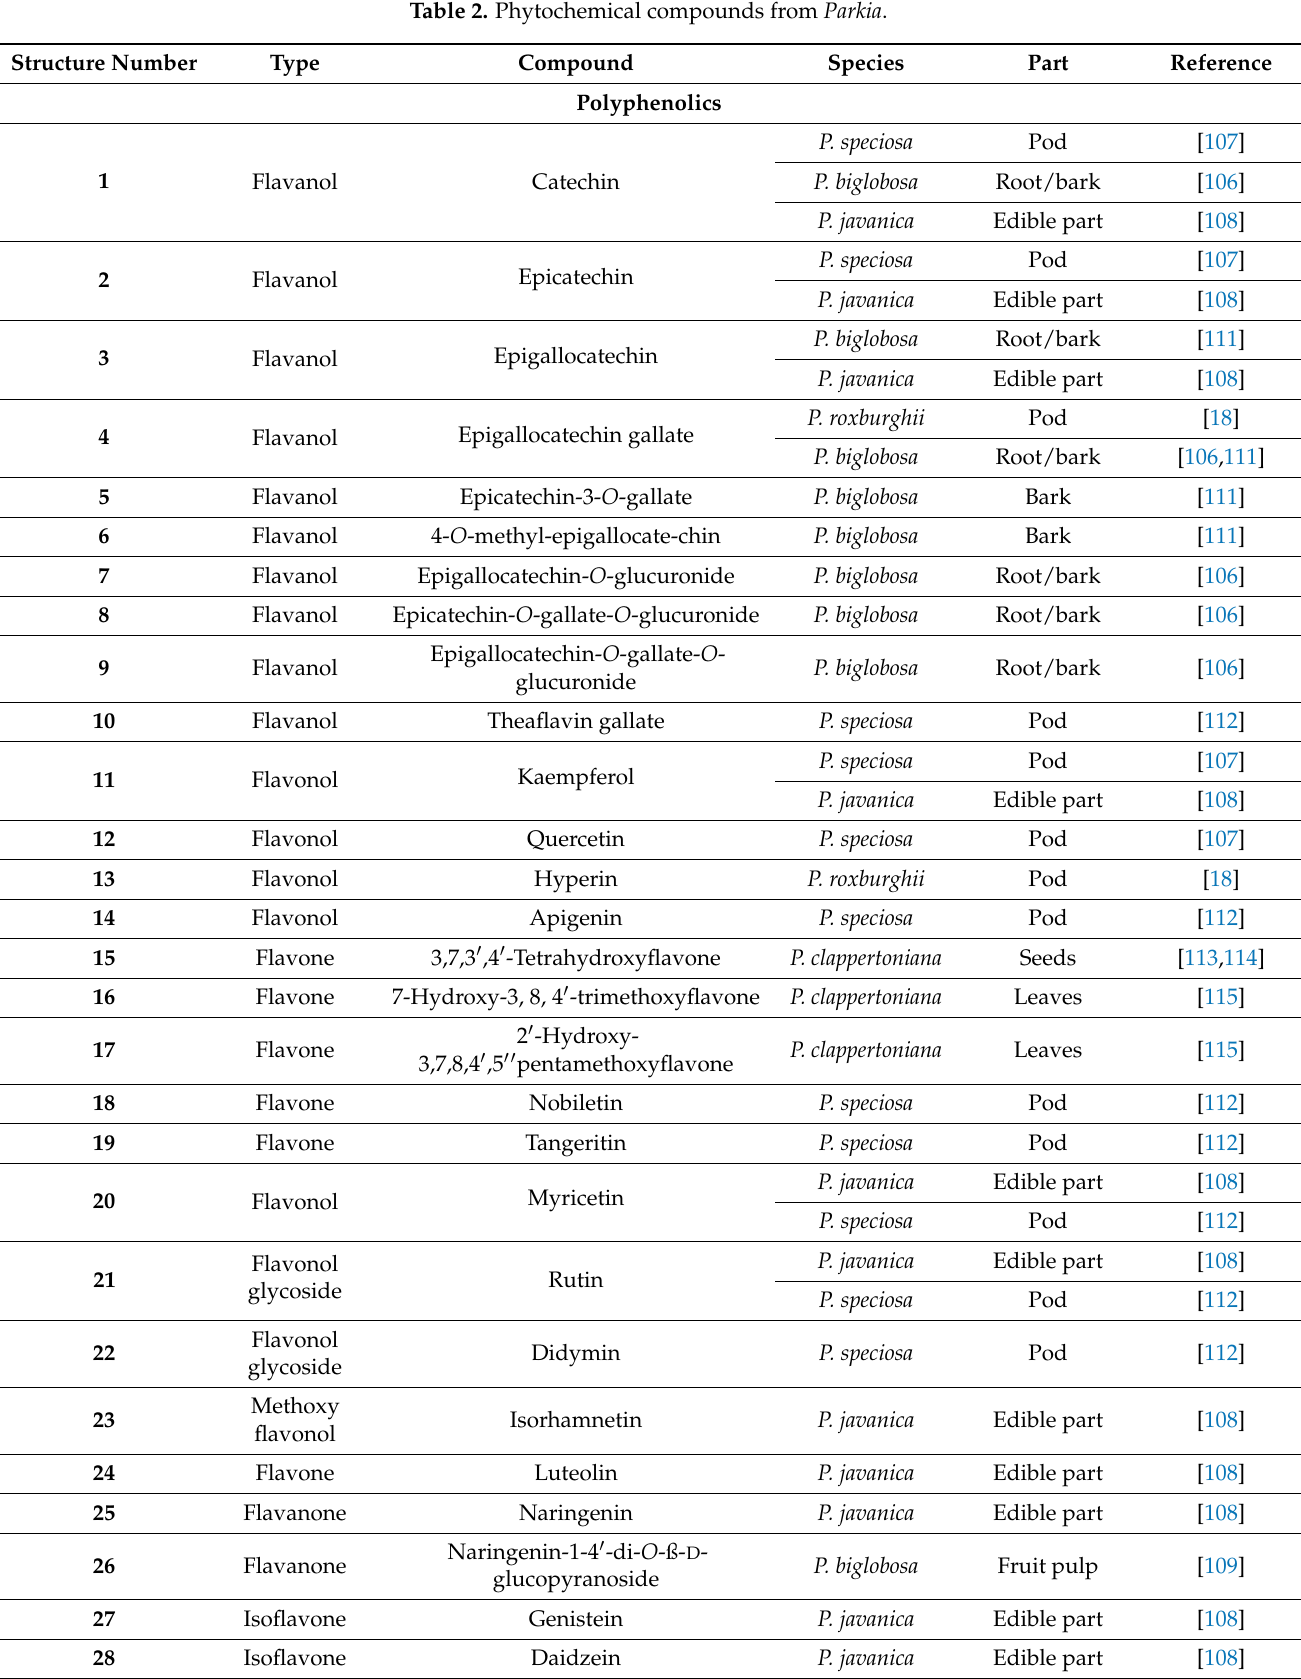
Table 2. Phytochemical compounds from Parkia